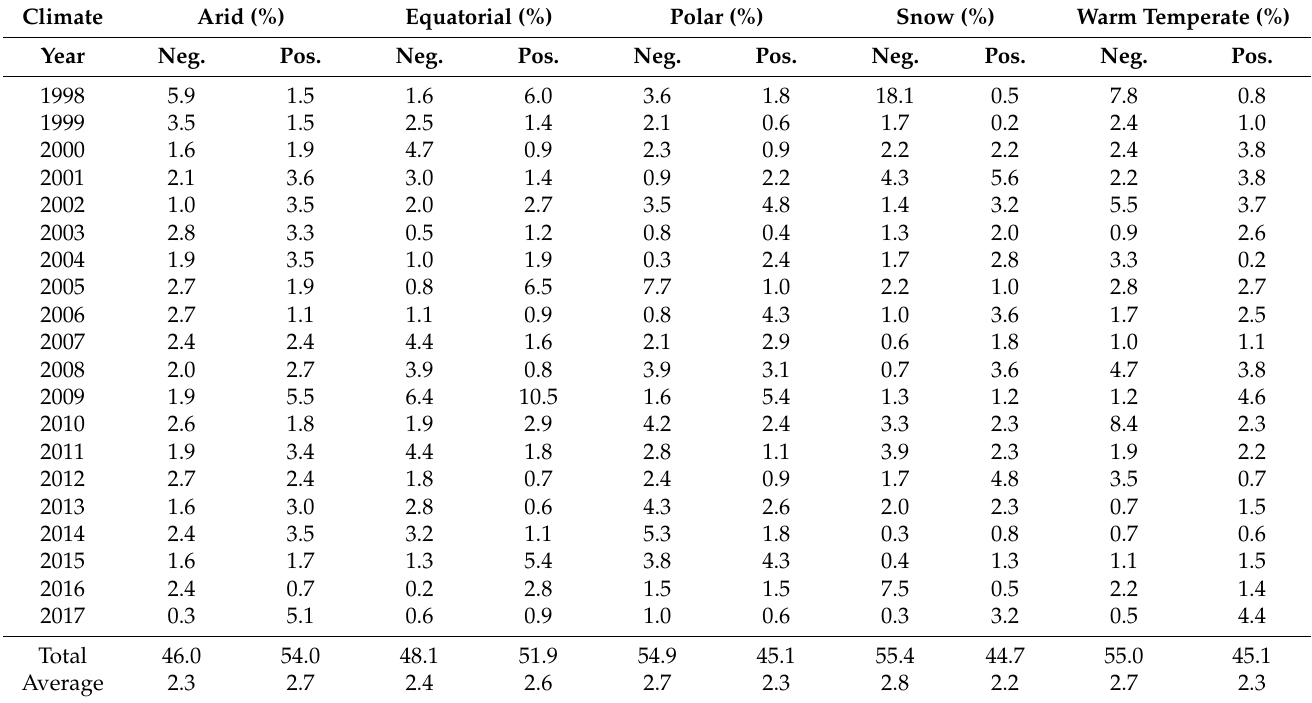
Table 3. Percentage of significant positive (Pos.) and negative (Neg.) breakpoints in precipitation for different climate zones.